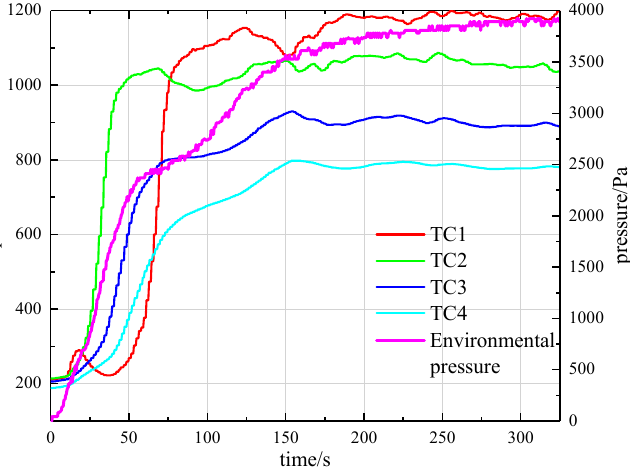
Figure 11. Temperature and pressure curves of a model thruster without the convergent nozzle carrying on the catalytic ignition experiment in the vacuum environment.